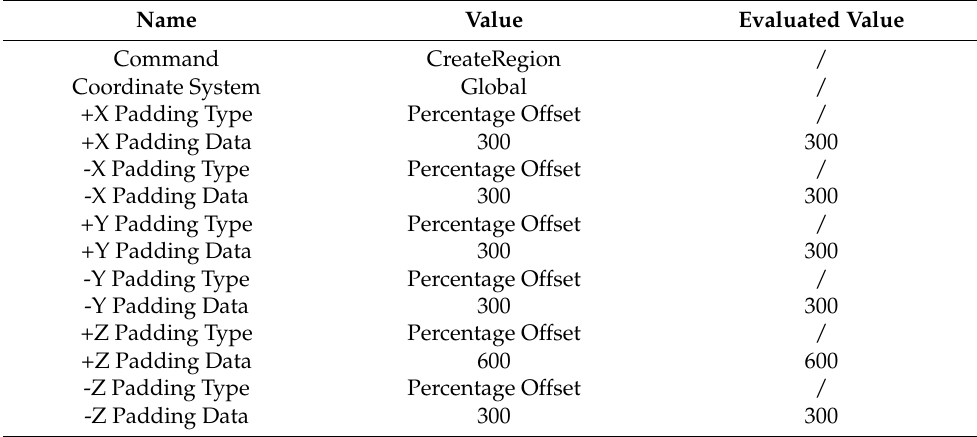
Table 1. Boundary condition parameter setting diagram.